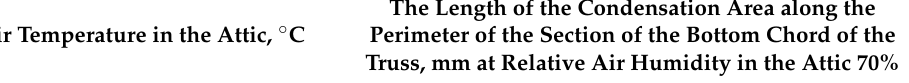
Figure 19. Calculation scheme without a gusset plate. The gaps between the angles and precast reinforced concrete elements are not filled with thermal insulation (units: mm). Table 7. The length of the condensation area along the perimeter of the section of the bottom chord of the truss, depending on the temperature and relative humidity of the air in the attic (calculation scheme without a gusset plate: the gaps between the angles and precast reinforced concrete elements are not filled with thermal